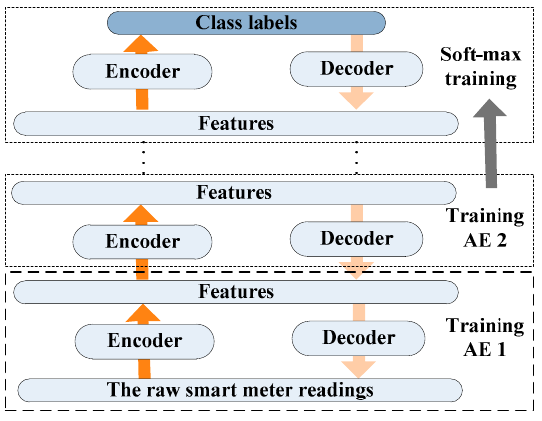
Figure 4. The greedy layer-wise training. Table 1. Procedure of the greedy layer-wise training and fine-tuning.